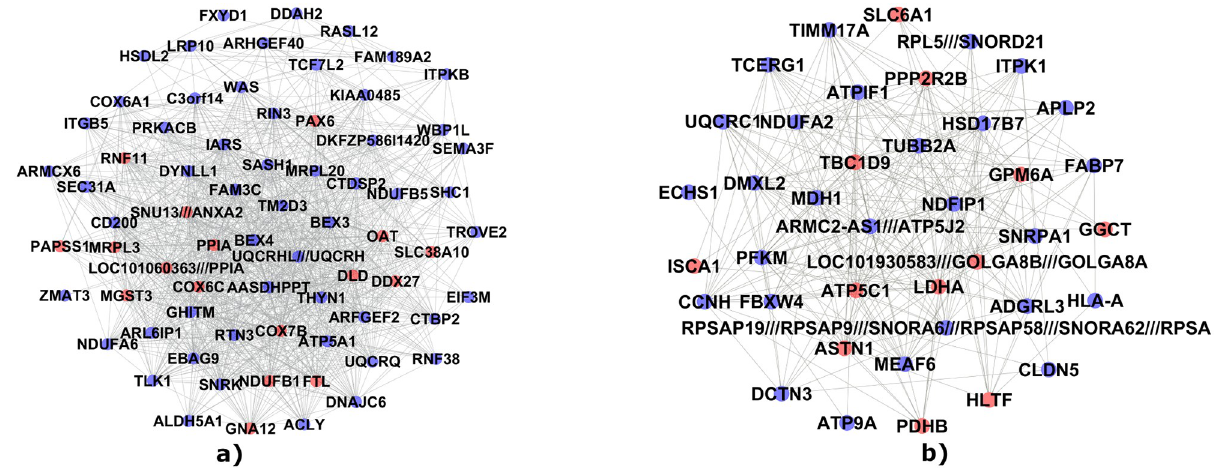
Fig 6. Schematization of C 1 and C 2 communities. Gene community C 1 (Panel a) and gene community C 2 (Panel b) composed by 72 and 39 genes respectively. In red we indicated genes significantly correlated with both clinical features simultaneously.